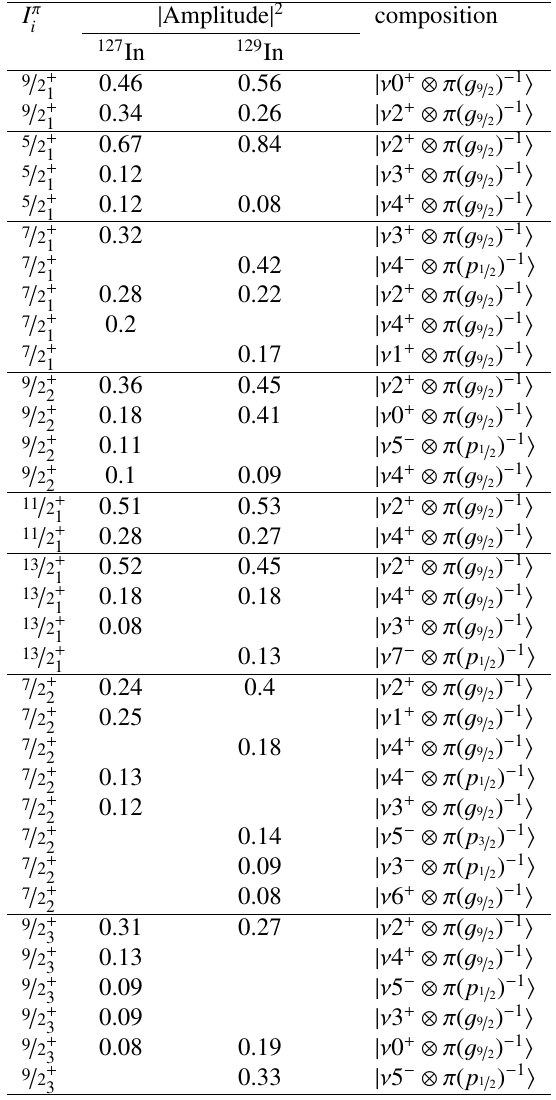
Table 2. Dominant wavefunctions components for In